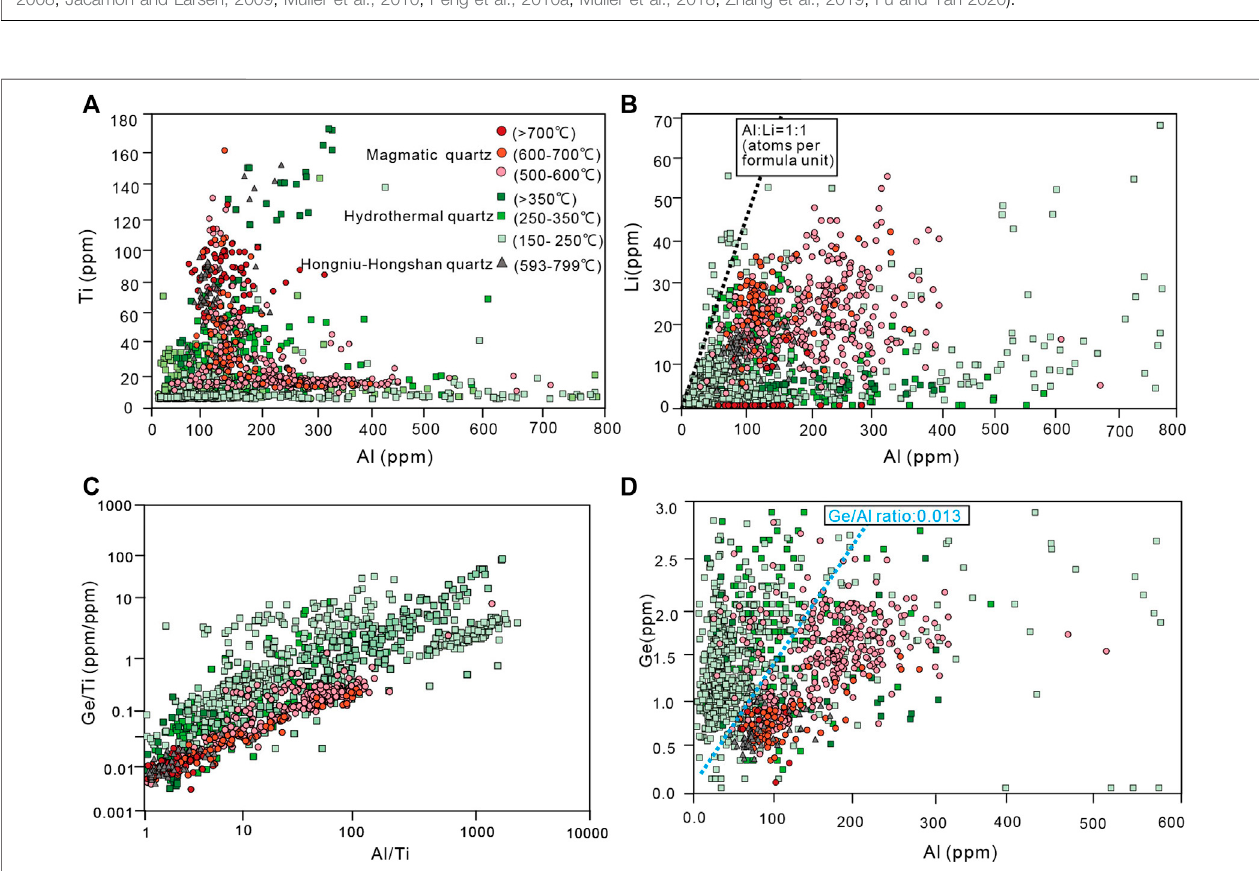
FIGURE13| Variabilityoftrace element concentrationsinmagmaticand hydrothermal quartzfrom14deposits (data fromGötzeet al.,2004;Mariane and Thoms, 2005; Rusk et al., 2008; Jacamon and Larsen, 2009; Müller et al., 2008, 2010; Peng et al., 2010a; Breiter et al., 2012, 2017a; Wertich et al., 2018; Müller et al., 2018; Zhang et al., 2019; Fu and Yan, 2020). A.Al versus Ti plot. B. Al versus Li plot. C. Al/Ti versus Ge/Ti plot. D. Al versus Ge plot.